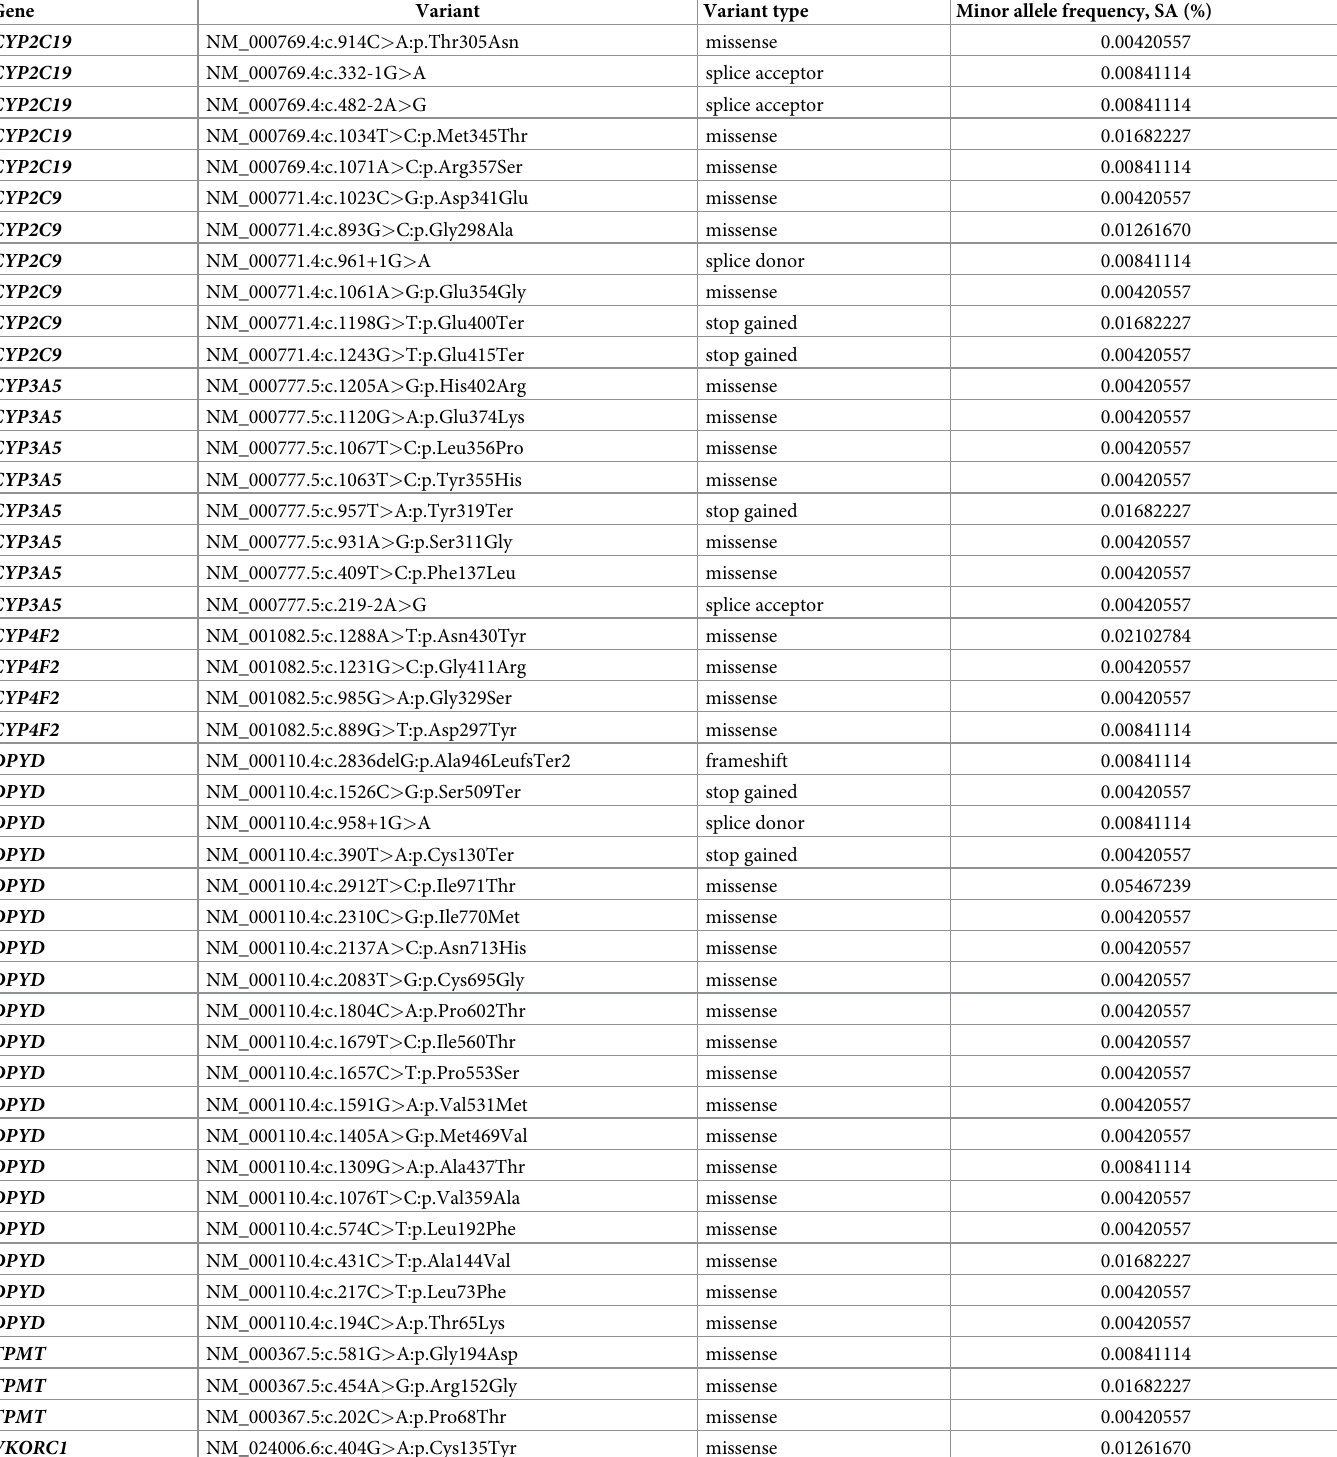
Table 3. Novel pharmacogenomics variants in Saudi